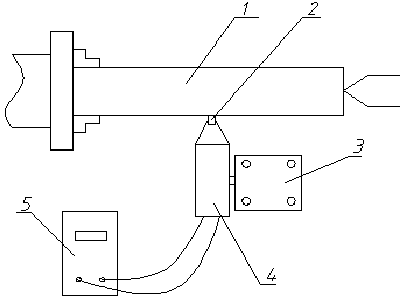
Figure 6. Schematic diagram of the ultrasonic surface strengthening system. 1-Workpiece; 2-Processing head; 3-Tool holder; 4-Trasducer; 5-Ultrasonic power supply.